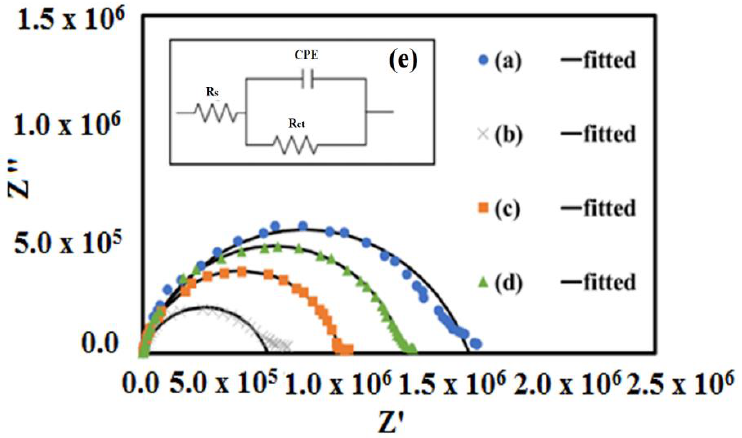
Figure 8. Nyquist plots of (a) STC, (b) STCM3, (c) STCM5, and (d) STCM7 and (e) circuit model used for curve